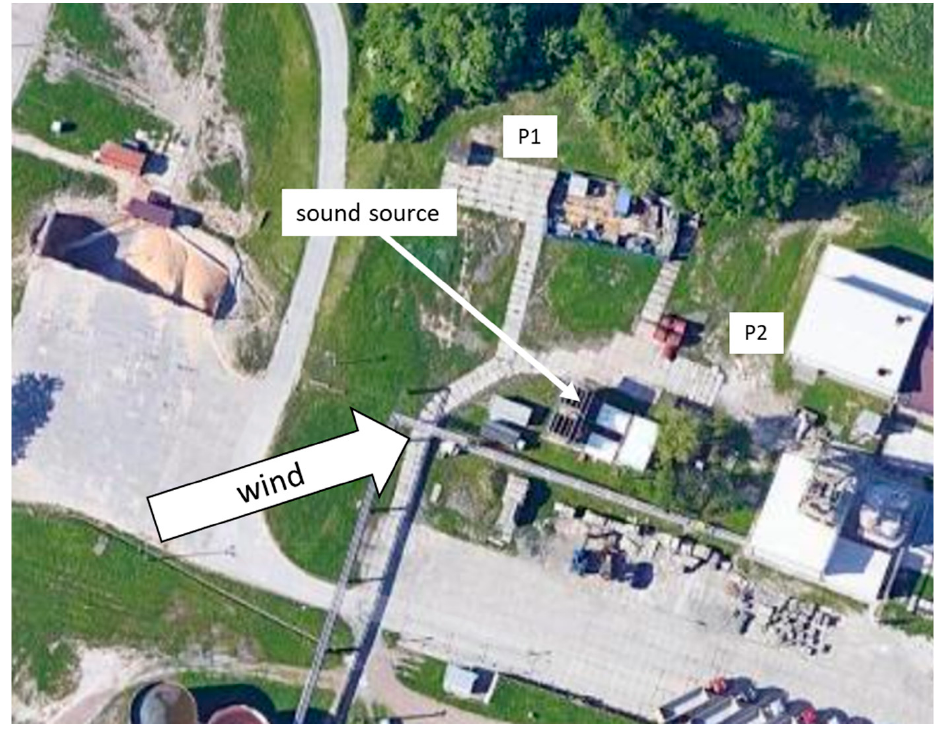
Figure 3. Placement of measurement points relative to the noise source. P1, P2—measurement points—source: google.maps.com.